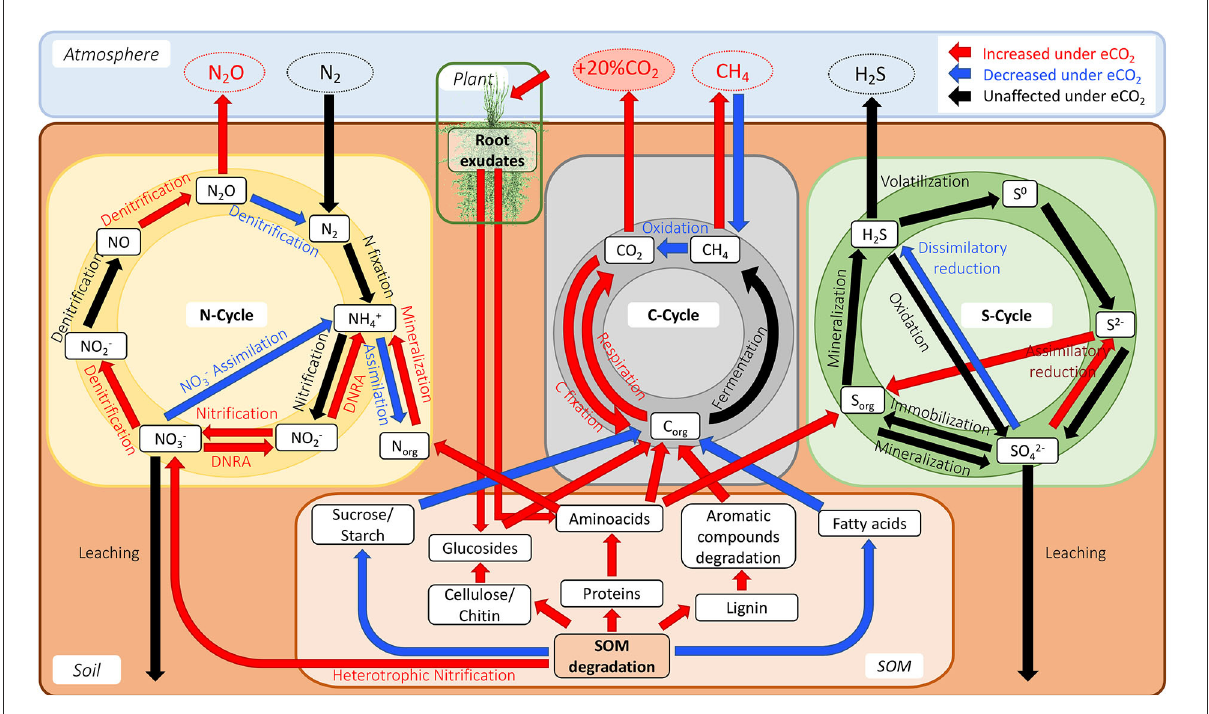
FIGURE7 Model diagram of the interaction of C, N, and S cycles in the